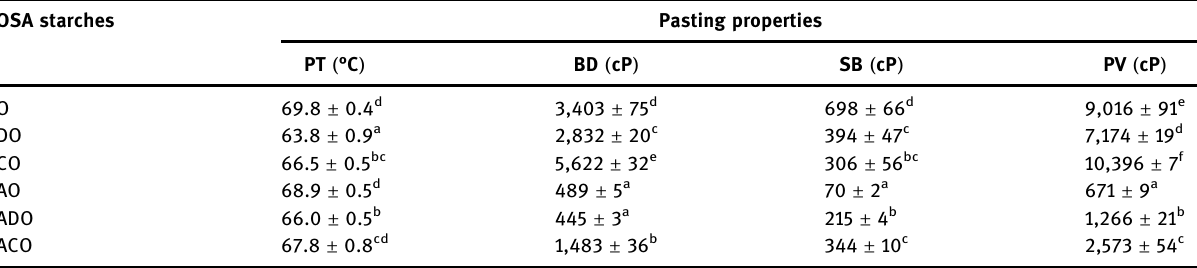
Table 6: Pasting properties of OSA starches OSA